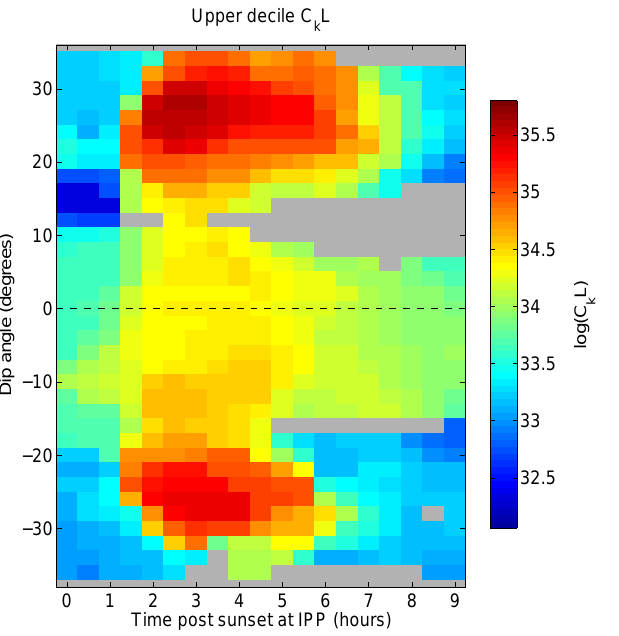
Fig. 13. As for Fig. 12 except here C k L was calculated using a variable height phase screen. See text for details.